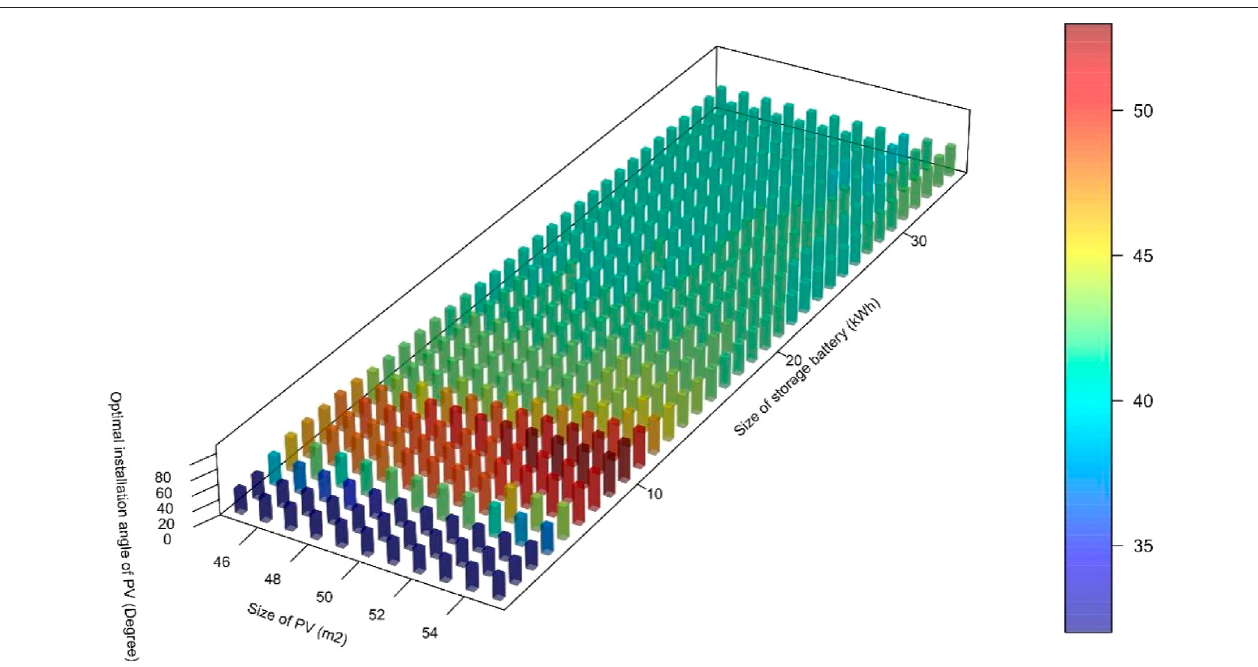
FIGURE 9 | Optimal PV installation angle for each case in the second run.